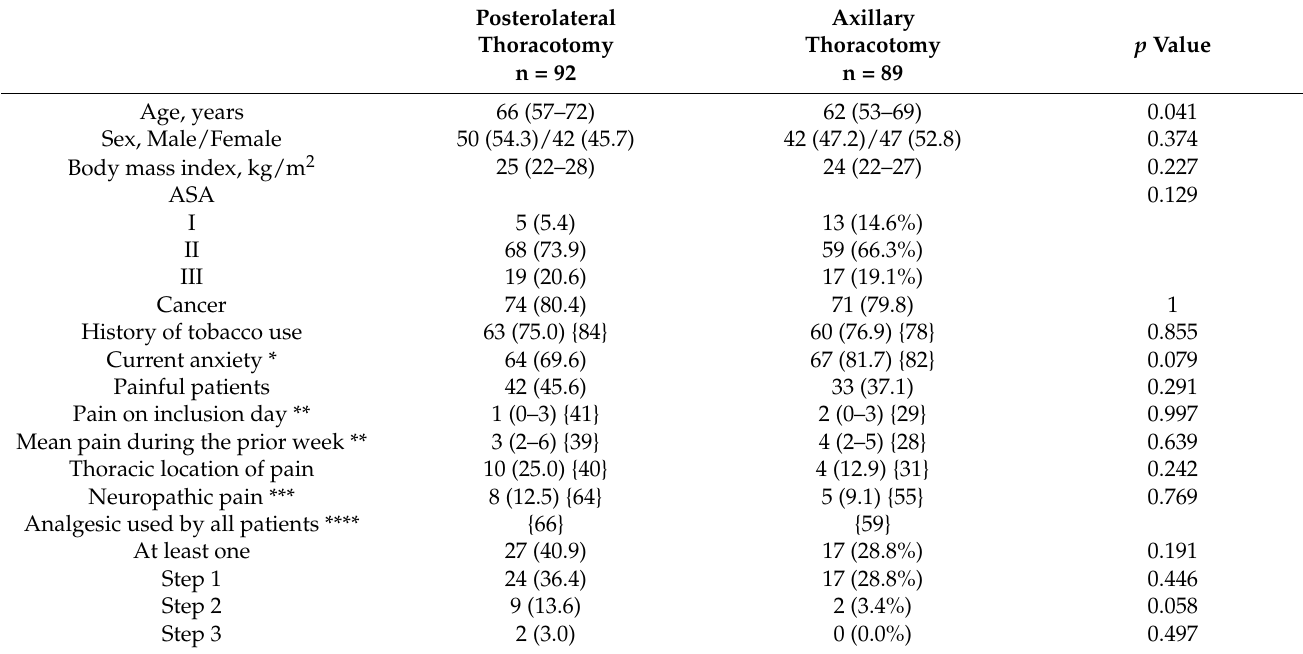
Table 1. Patient characteristics at inclusion in posterolateral and axillary groups. Posterolateral